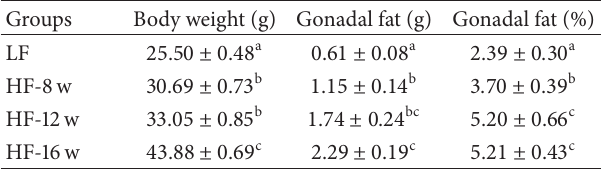
Table 2: Effect of diet and time on body weight and fat pad.